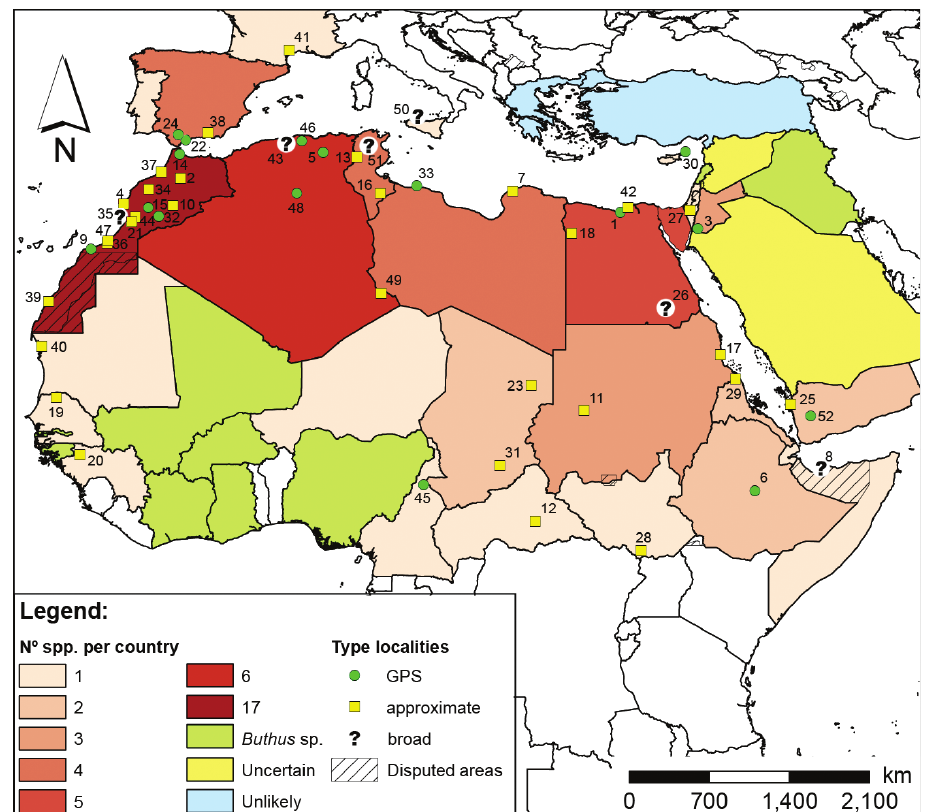
Figure 2. Map of Buthus species distribution, and the known number of species by country. Also de- picted are the species’ type localities (numbers according to the species’ Catalogue and Table 2) where known or the best possible approximation. Actual distribution within each country can be much smaller, but detailed distribution information is unknown for the majority of